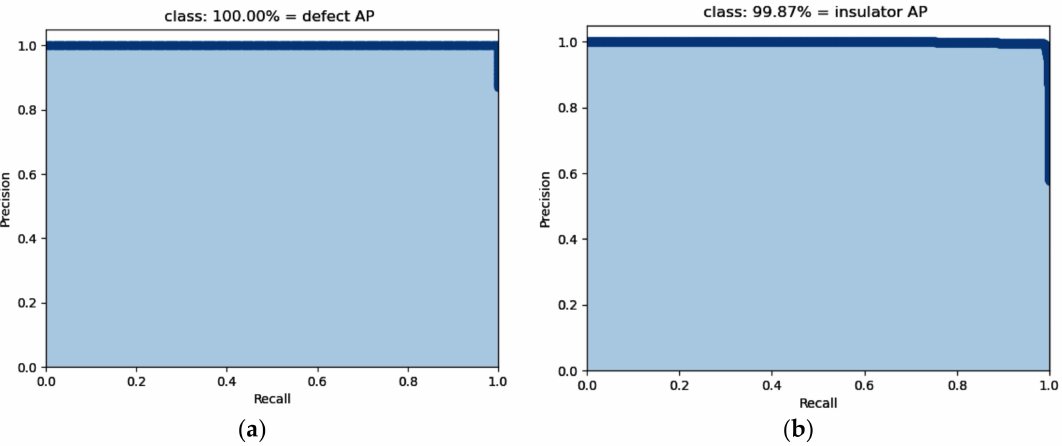
Figure 6. The PR curve and AP value of defective and normal insulators: ( a ) PR curve and AP value of defective insulators ( b ) PR curve and AP value of normal insulators.